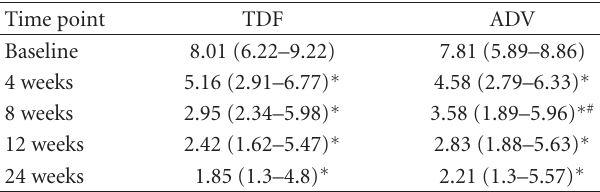
Table 2: Virological outcomes to tenofovir or